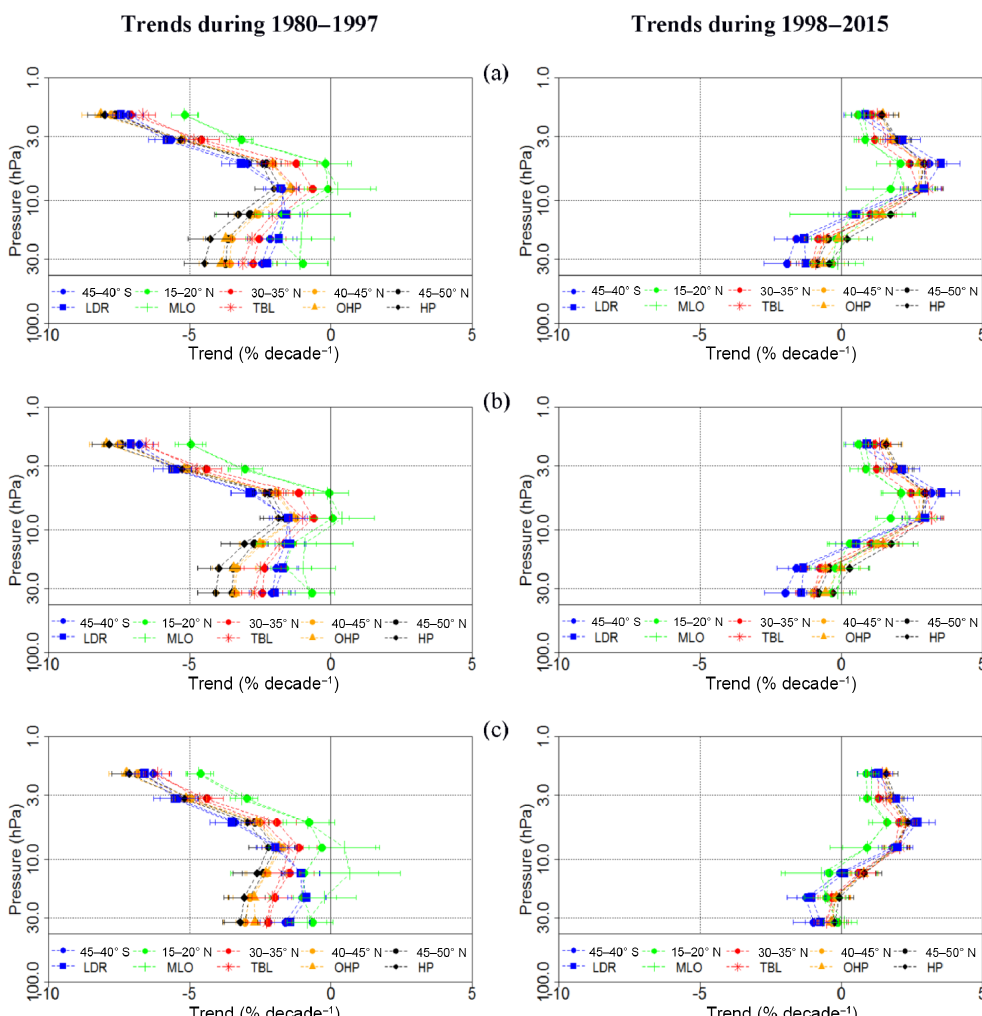
Figure 7. Trends in the vertical distribution of ozone for the pre-1998 and post-1998 period, based on SBUV station overpass and zonal mean data, using (a) two linear trend terms and volcanic effects only, (b) the PWLT method including all proxies and (c) using all proxies and two orthogonal EESC terms to describe the long-term ozone changes. The results are based on SBUV overpasses and SBUV zonal